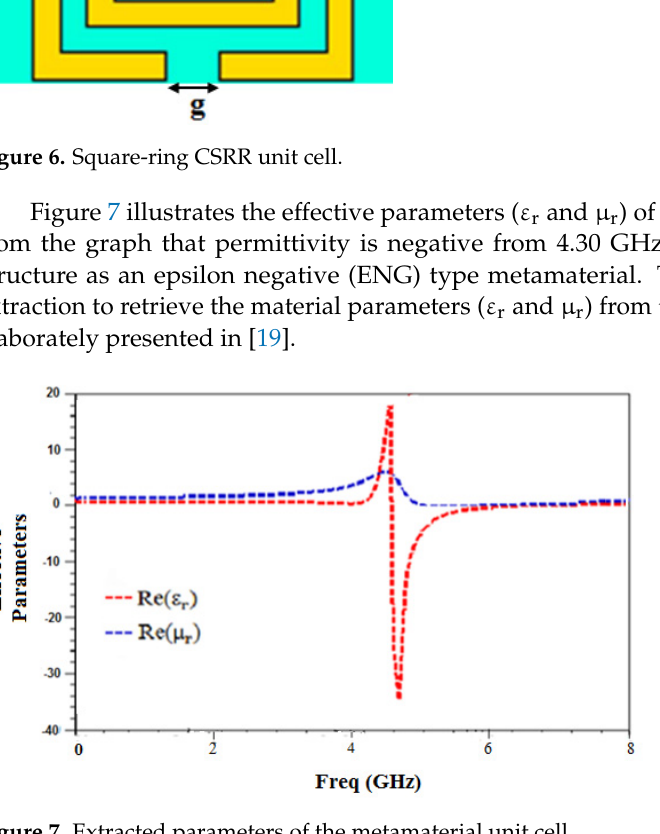
Figure 7. Extracted parameters of the metamaterial unit cell.